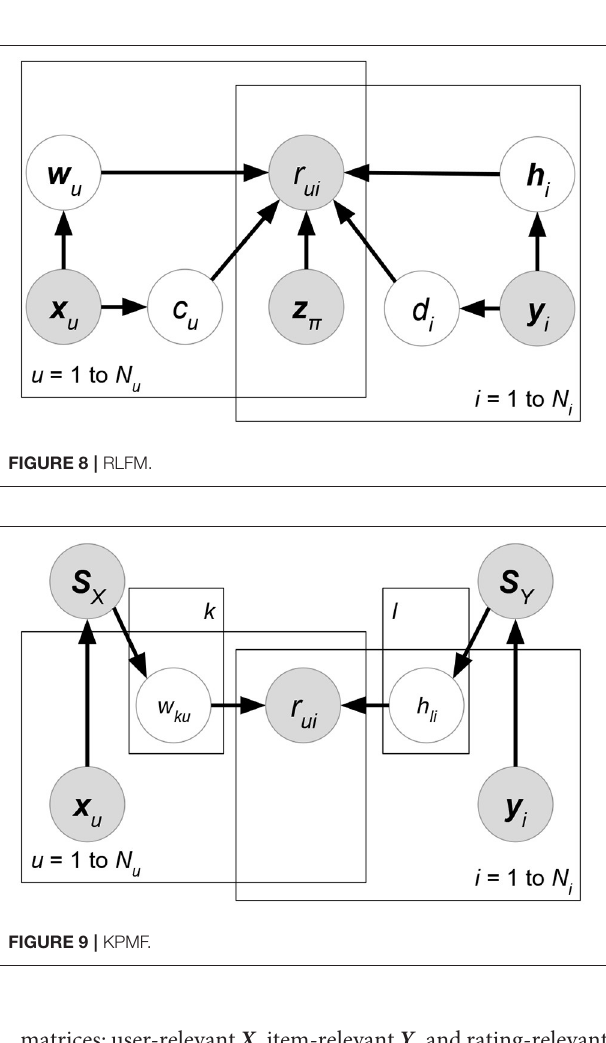
matrices: user-relevant X , item-relevant Y , and rating-relevant Z , RLFM models them in different parts of biased matrix factorization. X , Y serve as the hyperparameters of latent factors, while Z joins the regression framework to predict ratings together with latent factors. RLFM can be written as: